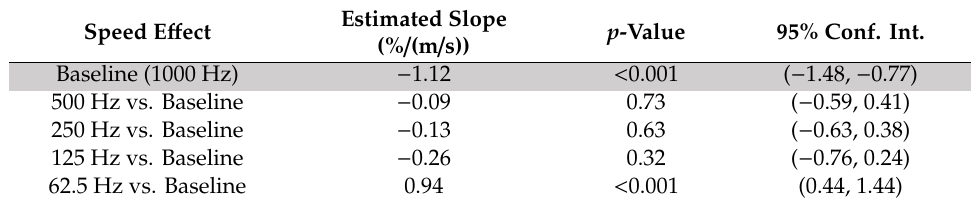
Table A3. E ff ect of speed on the cumulative distance versus sampling frequency for Method 1 (downsampling). First (shaded) row reports the estimated slope of the cumulative distance traveled versus mean speed using the baseline sensor (1000 Hz). Remaining (unshaded) rows report the estimated di ff erences in this slope for IMUs with the indicated sampling frequency compared to the baseline IMU (i.e., the increased error sensitivity to speed following the indicated reductions in sampling frequency relative to the baseline sampling frequency).